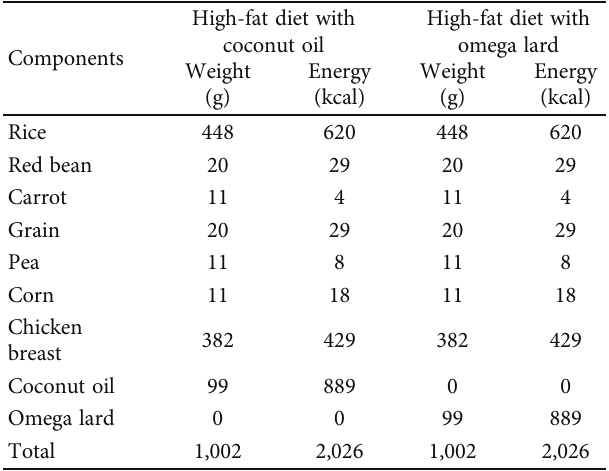
Table 3: Composition of semisolid coconut oil diet and omega lard diet. High-fat diet Components